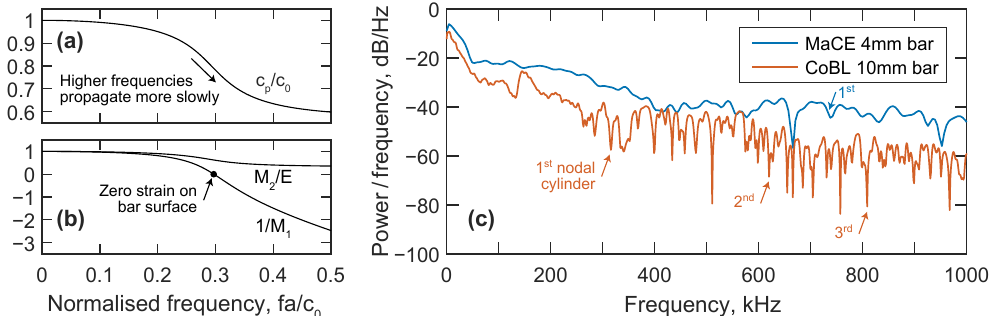
Figure 4. ( a ) Relationship between phase velocity, c p , and one-dimensional wavespeed, c 0 , with varying normalised frequency for the first mode of propagation ( ν = 0.29). ( b ) Values of 1/ M 1 and M 2 / E with varying normalised frequency for the first mode of propagation. The labelled point indicates the frequency where a nodal cylinder exists on the surface of the bar: zero strain is recorded on the bar surface despite a non-zero internal strain. ( c ) Power spectral density of MaCE and CoBL measurements indicating the frequencies where nodal cylinders